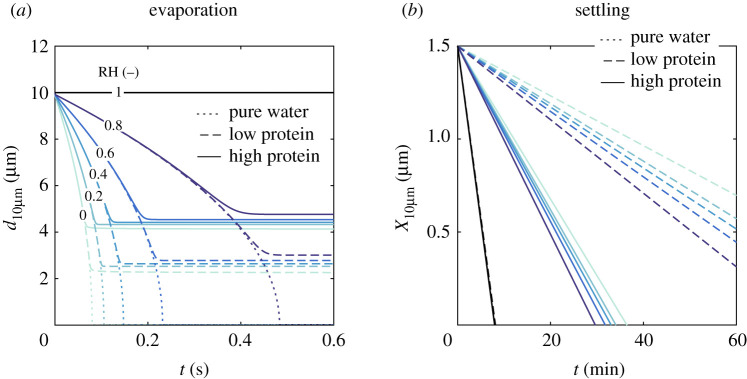
Impact of the droplet composition modelling approach (pure water; sputum 9 mg ml−1 NaCl, 3 mg ml−1 protein; sputum 9 mg ml−1 NaCl, 76 mg ml−1 protein) on the (a) evaporation and (b) settling of 10 μm droplets under different relative humidities. The relative humidity is shown in colour (RH = 0–100%)—T = 20°C. (Online version in colour.)